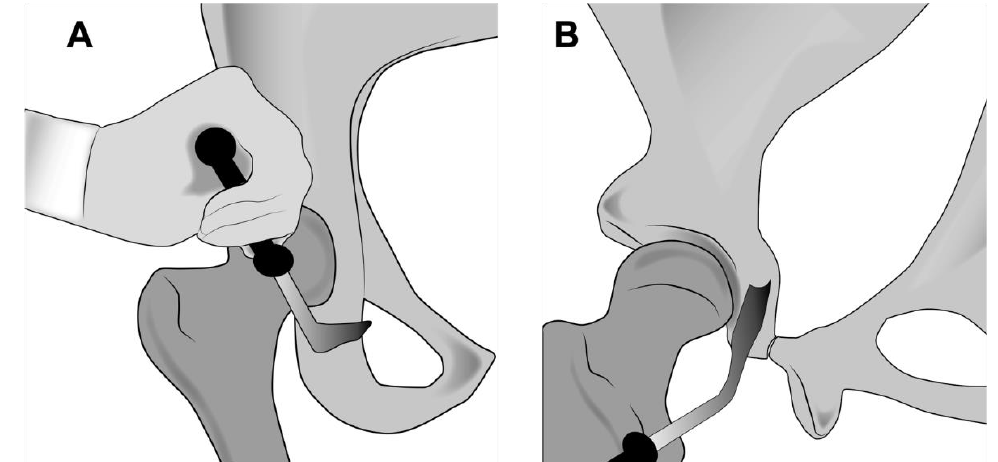
Figure 6. ( A ) Illustration showing the subcotyloid cut performed with an angled Ganz osteotome. ( B ) An illustration of a side view of the posterior column depicting the incomplete ischial cut